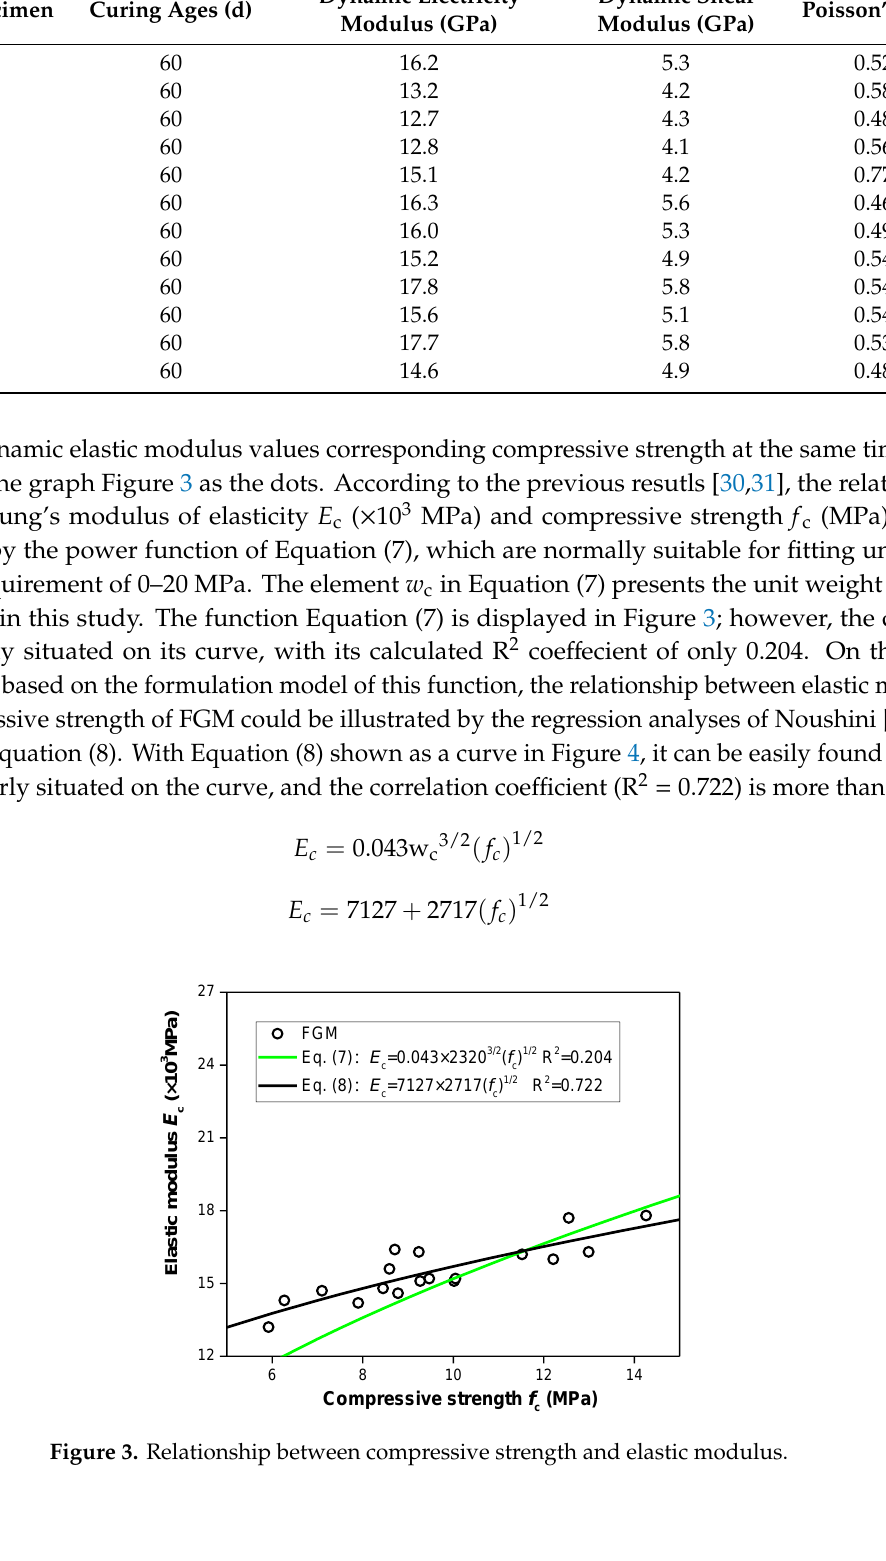
(d) Figure 4. Comparison of stress – strain curves in different FGM specimens. ( a ) Coal gangue types and binder volume effect; ( b ) Aggregate gradation effect; ( c ) Fly ash proportion effect; ( d ) Water to binder ratio effect. 3.3. Stress – Strain Relationship Figure 4 presents the stress – strain curves of different FGM and shows how the curves were influenced by the related variables in this research. In Figure 4a, the slopes of the ascending segment among the four curves (I\II\III\IV-78) were similar, and B-11 ascending segment looks less steep.